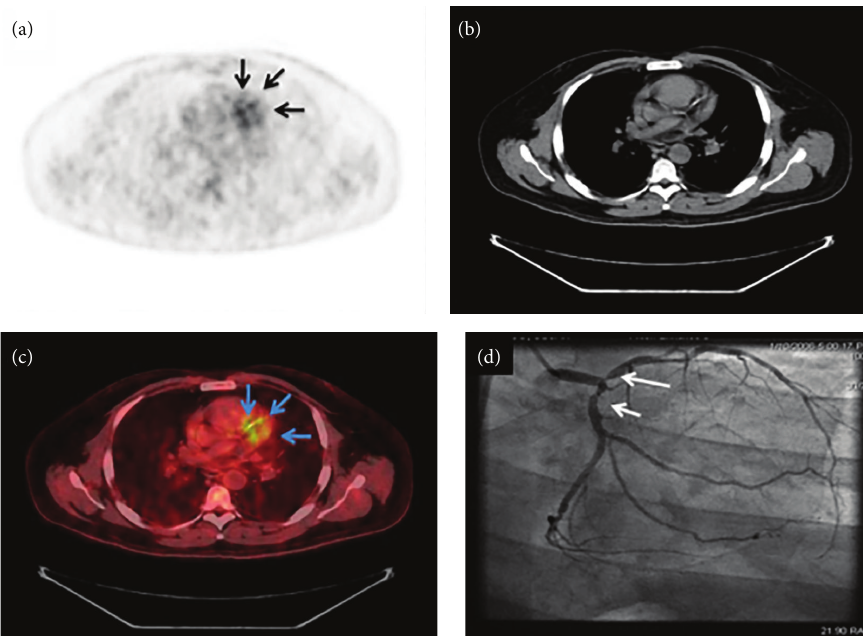
Figure 4: Representative images of coronary tree FDG uptake with corresponding angiographic images. Representative images of the coronary tree FDG uptake (arrows). FDG PET (a). CT (b). PET/CT (c) and coronary angiography (d) from patient with good myocardial uptake suppression with a low carbohydrate, high fat preparation. Reprinted with permission from Wykrzykowska et al.